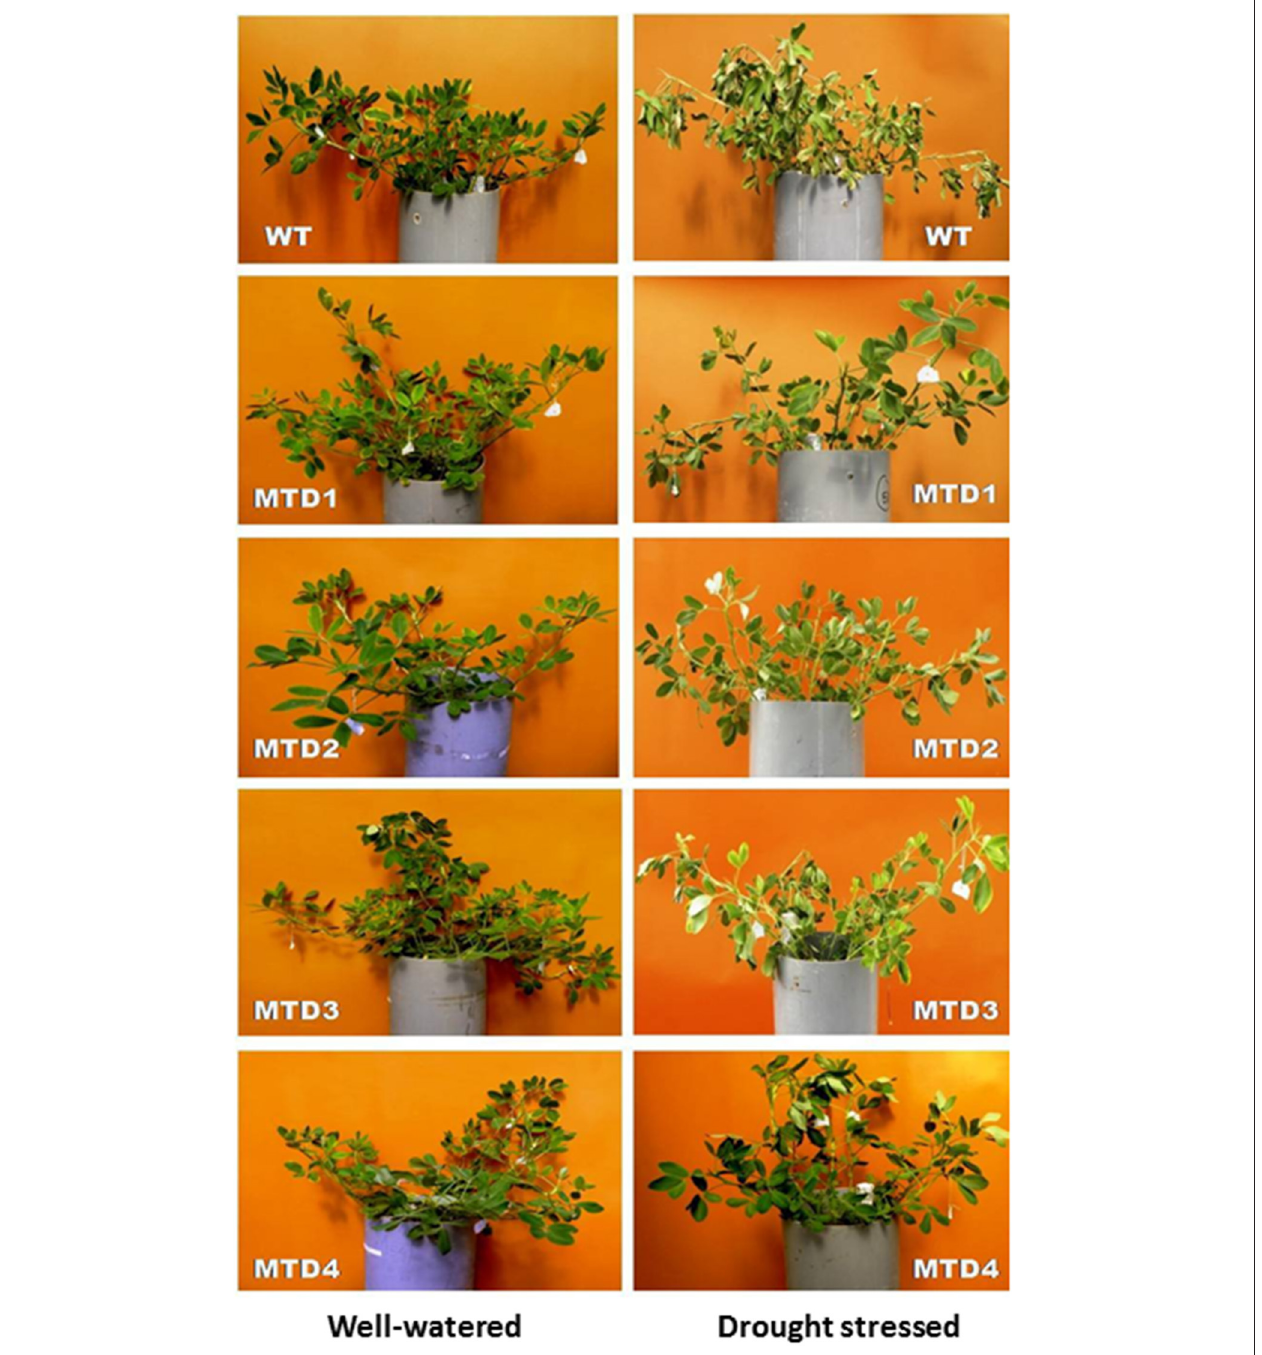
FIGURE 4 | Comparisons of phenotypic traits between wild-type and transgenic lines at 24 days under well-watered and drought-stressed